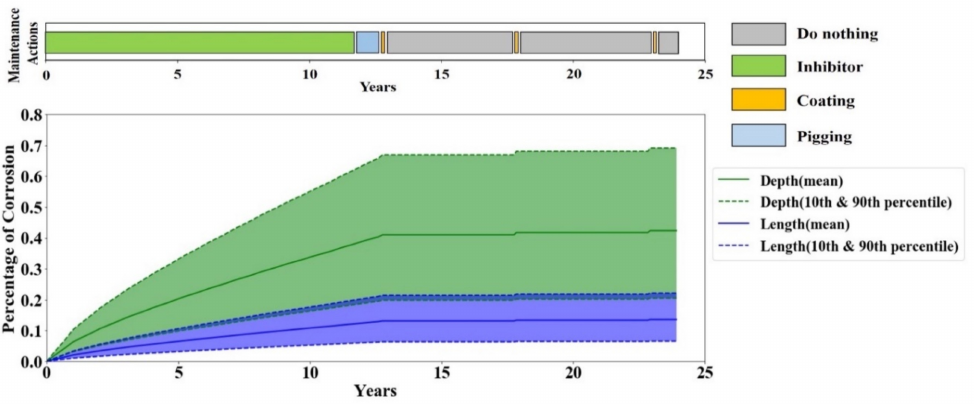
Figure 9. Corrosion depth and length in one full-life evaluation episode for sensitivity scenario one.